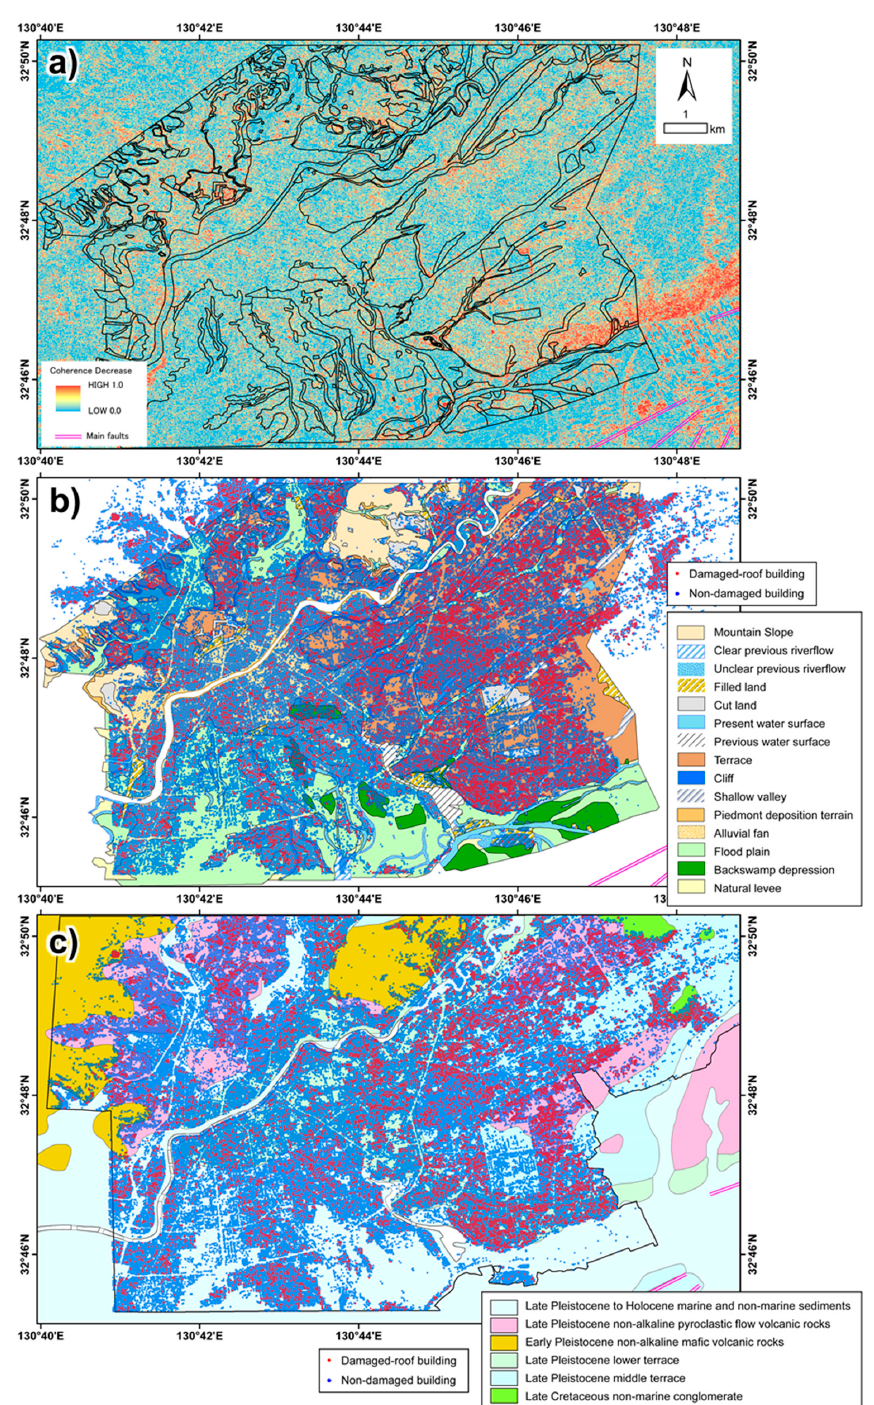
Figure 4. Spatial distributions of ( a ) coherence decrease, buildings covered/non-covered with plastic sheets overlaid ( b ) on the geomorphological classification map and ( c ) on the geological map. The locations of these panels are the equivalent of (A) in Figure 1.